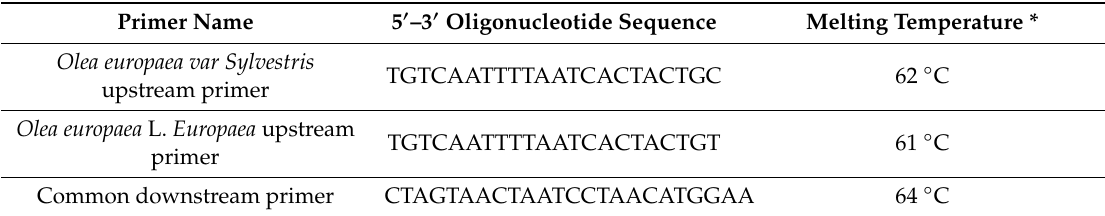
Table 1. The primers used in the allele-specific, real-time PCR, two species-specific upstream primers and a common downstream primer, along with their melting temperatures